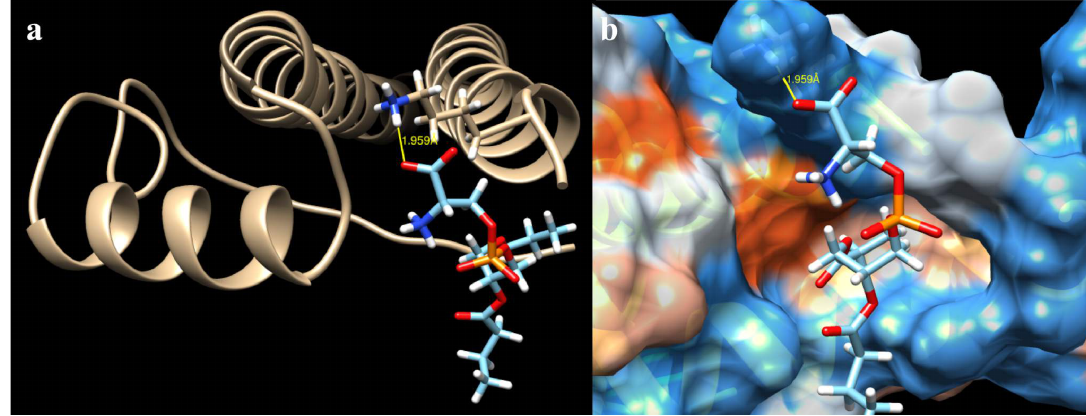
Figure 6. CagA–PS interaction of the 4DVY crystal obtained from Chimera: ( a ) hydrogen bonds and their distance (yellow lines) of interacting atoms are shown for both molecules; and ( b ) hydrophobic surface view of CagA, color-coded from dodger blue for the most hydrophilic, to white, to orange-red for the most